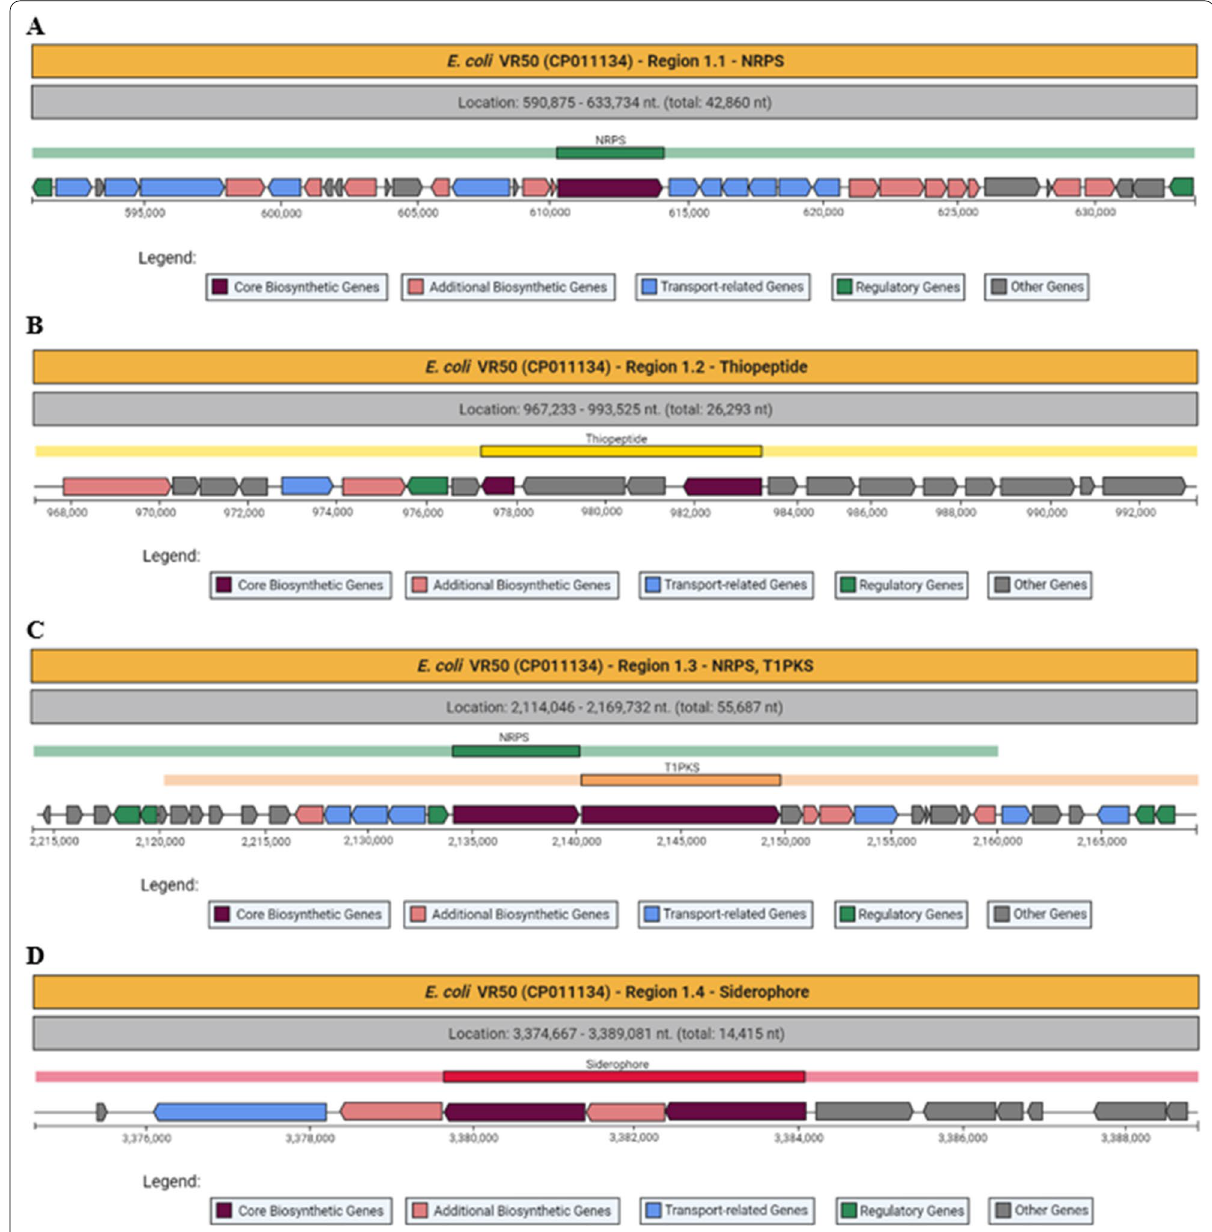
Fig. 6 Region 1.1 responsible for the biosynthesis of enterobactin and transport ( A ); Region 1.2 thiopeptide biosynthetic gene cluster ( B ); Region 1.3 responsible for NRPS and PKS genes related to yersiniabactin biosynthesis ( C ); Region 1.4 siderophore biosynthetic gene cluster ( D ) in E. coli